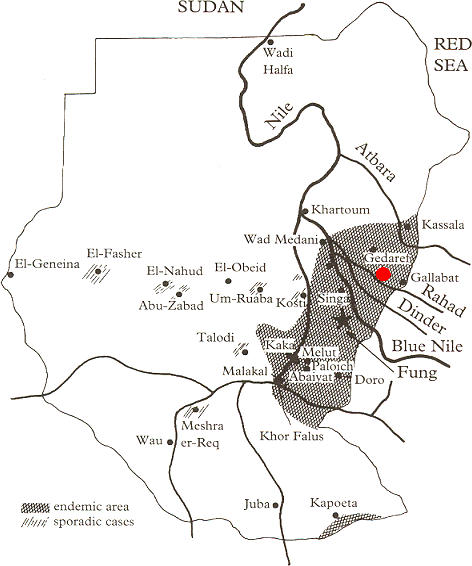
Map of Sudan Showing Locations of Viseral Leishmaniasis Study Sites in Sudan.Locations of El-Rugab and Um-Salala villages (red dot) used in this study are shown in relation to Barbar El Fugura village (near Gedaref) used in the earlier study of Bucheton et al. [13]. Areas endemic for visceral leishmaniasis, or where sporadic cases occur, are marked on the map. Modified with permission from Zijlstra et al. [34].